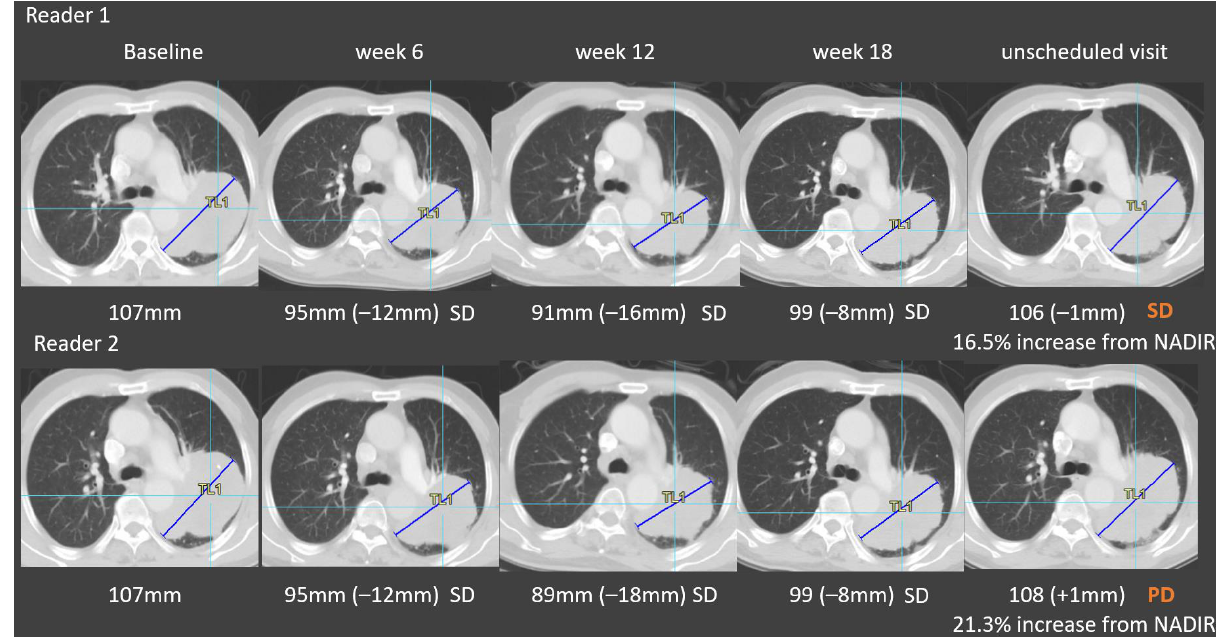
Figure 6. Variability in target lesion measurements. Reader 1 and reader 2 selected the same target lesion at baseline. Even though the two readers performed very similar subsequent measurements, at the third visit, a small measurement difference triggered discrepant responses. At the final visit, one reader declared a stable disease (SD) whereas the other reader declared a progressive disease (PD).